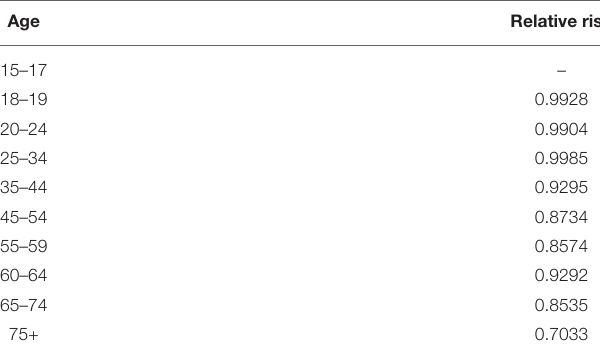
TABLE 5 | Relative risk of death between Disability-Free and frail